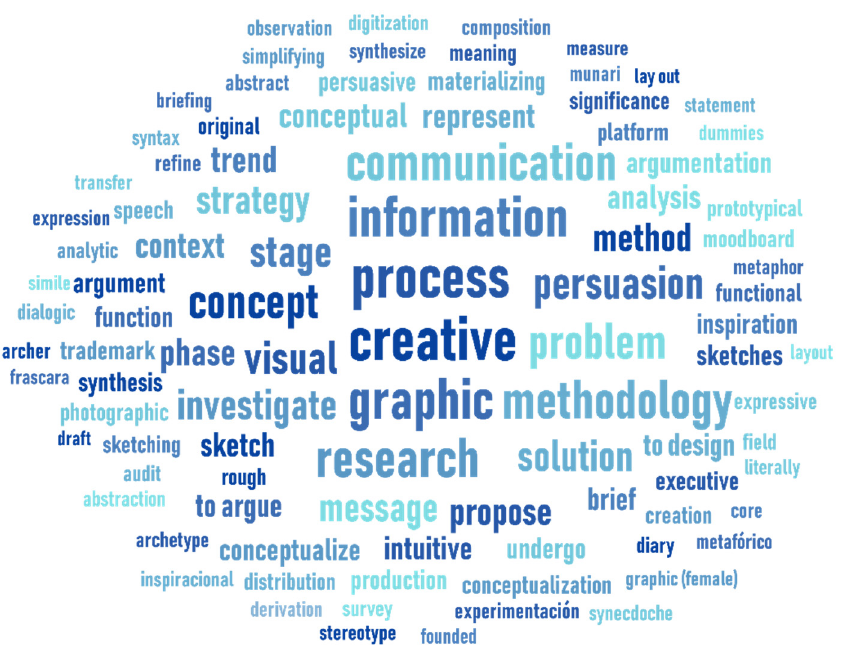
Figure 5. Concepts related to the design method mentioned by the interviewees (own elaboration). Table 3. Relationship between the phases of the design method and the intellectual operations of the designer (own elaboration). Method Stages